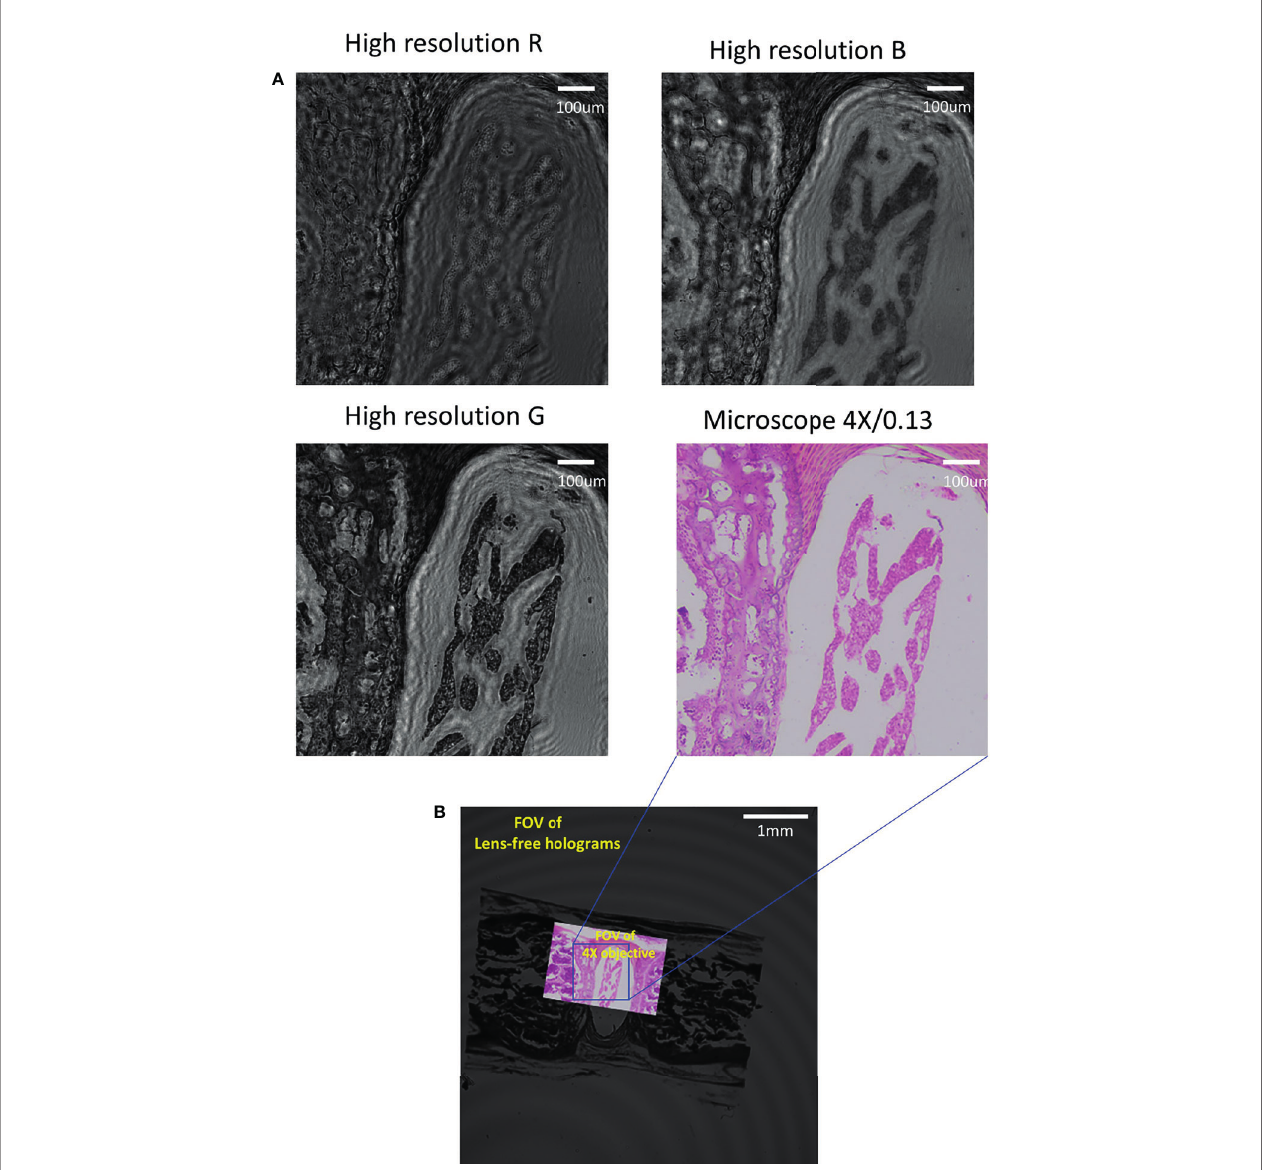
FIGURE 4 | Comparing high-resolution images in R, G and B channels of red marrow smears with traditional bright- fi eld microscopy. (A) The high-resolution images of each band were compared through the image acquired by the microscope (4X/0.13). (B) FOV comparison between the lensfree microscope and the traditional bright- fi eld